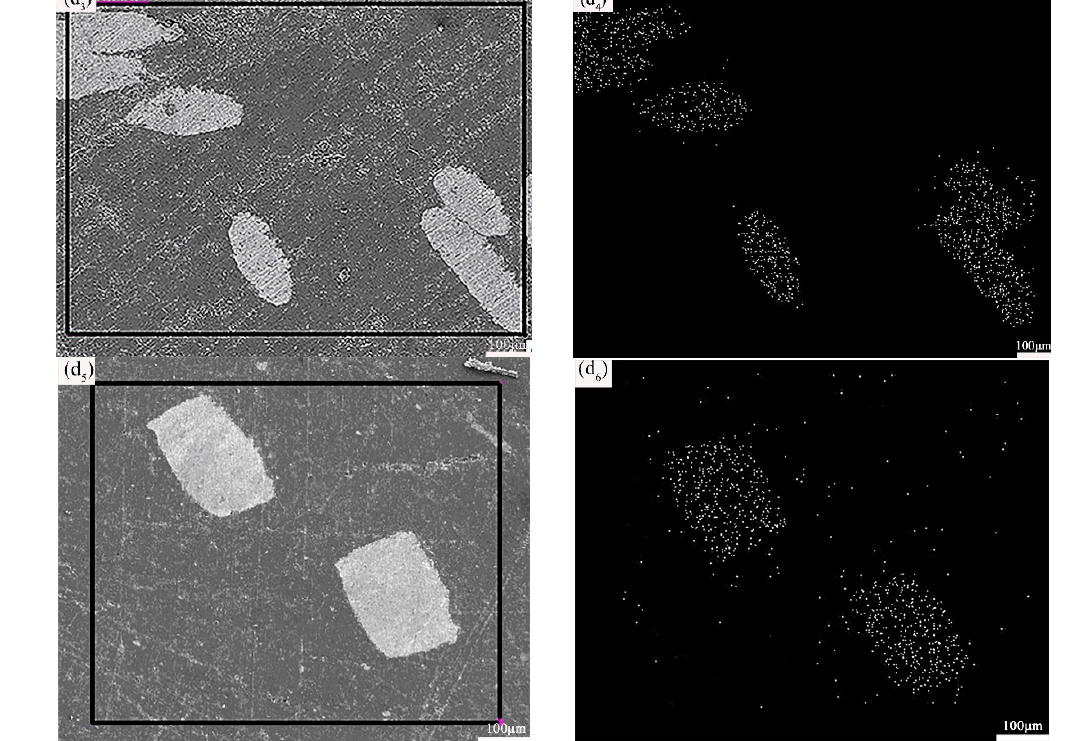
Figure 4. ( a ) Impact strength and resistivity and ( b ) friction coefficient and abrasion loss of Cu − filled slide specimens with different morphologies. Impact fracture morphology of the Cu − M − filled slide specimens of ( c 1 ) Non − Cu, ( c 2 ) Cu − P, ( c 3 ) Cu − F, and ( c 4 ) Cu − M. SEM and EDS images of ( d 1 , d 2 ) Cu − P; ( d 3 , d 4 ) Cu − F; and ( d 5 , d 6 ) Cu − M − filled slide specimens.